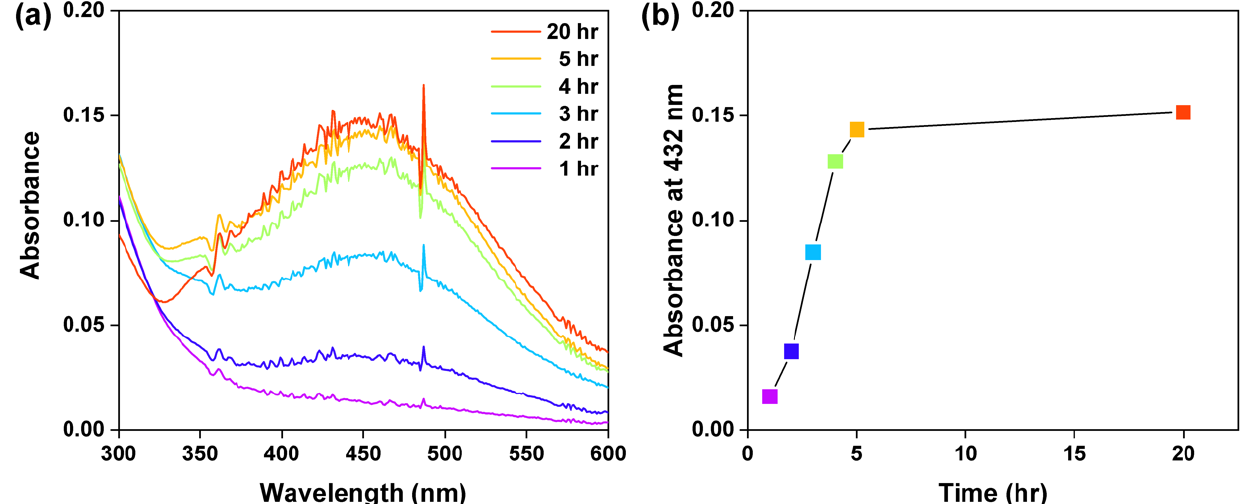
Figure 1. ( a ) UV–Vis spectra and ( b ) UV–Vis absorbance at 432 nm (the characteristic peak) of Ag NPs synthesized at 25 °C with various reaction times with 0.5 mg mL − 1 EPS-1 and 10 mM AgNO 3 solution.